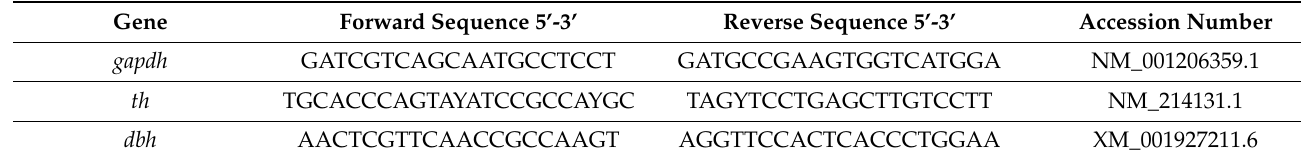
Table 2. Primers used in the